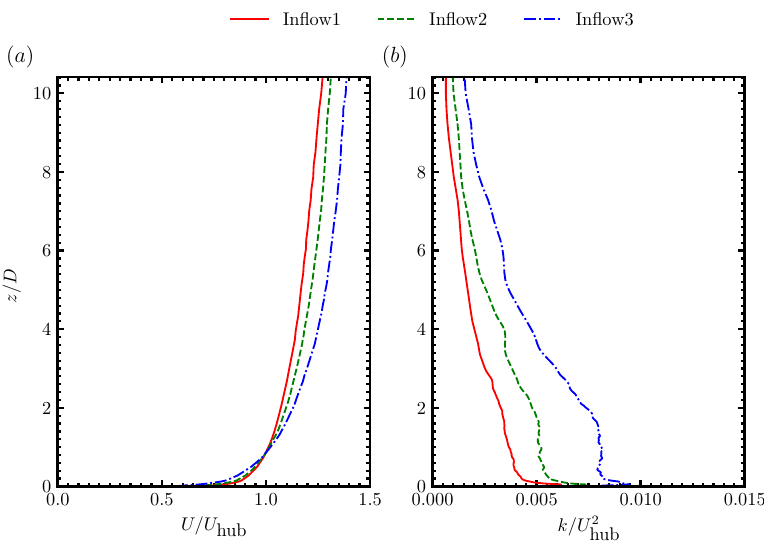
Figure 2. Vertical profiles of ( a ) mean streamwise velocity and ( b ) turbulence kinetic energy. The power and thrust of the waked turbine, which were normalized using that of the first turbine, are shown in Figure 3. As expected, the normalized power ( P 2 / P 1 ) and thrust ( T 2 / T 1 ) increased with downwind turbine spacing and the increase of the inflow turbulence intensity, as the former one increased the downwind distance for wake recovery and the latter one increased the rate of wake recovery.